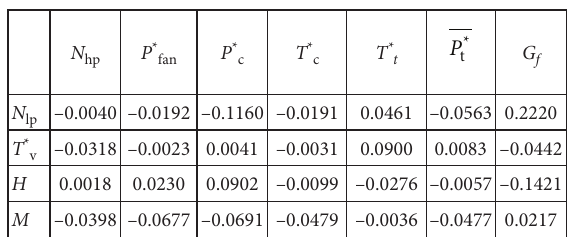
Table 2. Correlation factors between diagnostic deviations